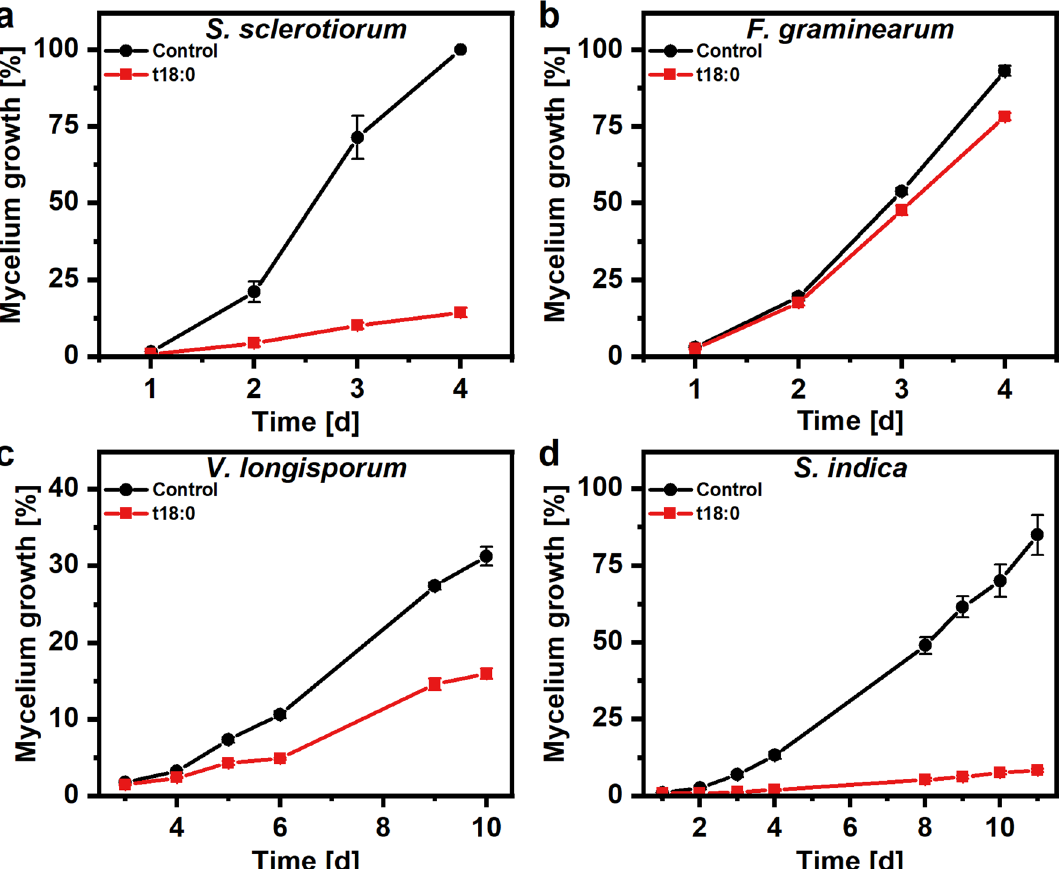
Figure 1. Phytosphingosine inhibits growth of fungal hyphae on agar medium. ( a ) Sclerotinia sclerotiorum , ( b ) Fusarium graminearum , ( c ) Verticillium longisporum and ( d ) Serendipita indica . Agar plates contained different media optimal for each fungus (see “Material and methods”). Media were supplemented with either 80 µM phytosphingosine (t18:0) or were prepared with solvent (1% DMSO; Control) only. Plates were inoculated in the center with a mycelial plug ( a , b , d ) or 10 µL of spore solution (containing 5000 spores) ( c ), and growth of mycelia on the surface of the medium was documented over time. Mycelial growth is presented as the percentage of the total area of the plate covered by the mycelium. Values are means of 9–15 plates, with error bars indicating standard error of the mean